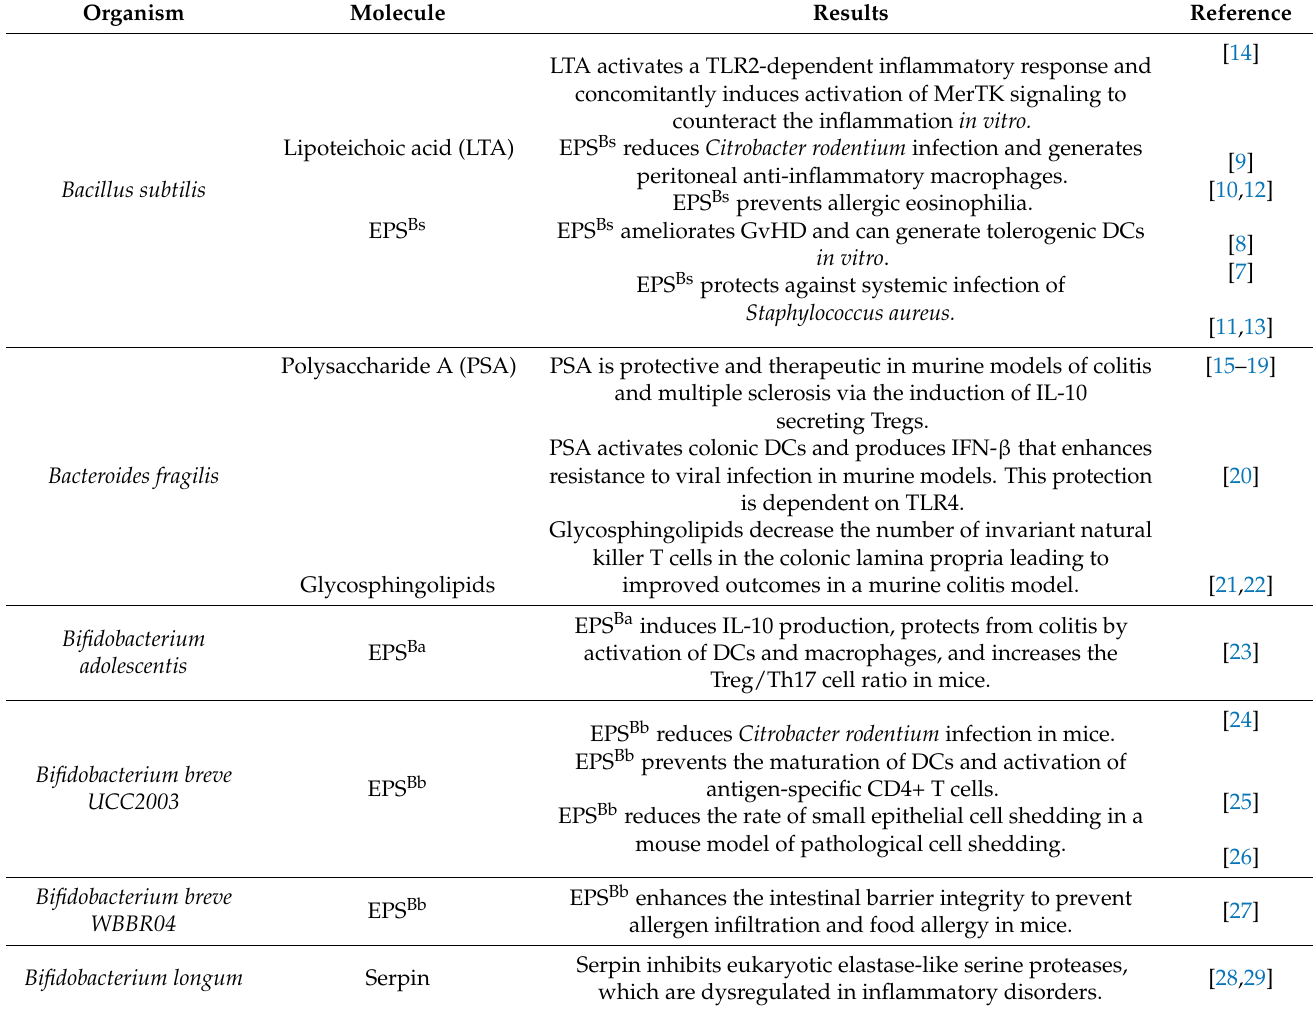
Table 1. Probiotic bacterial molecules with anti-inflammatory activity. Results